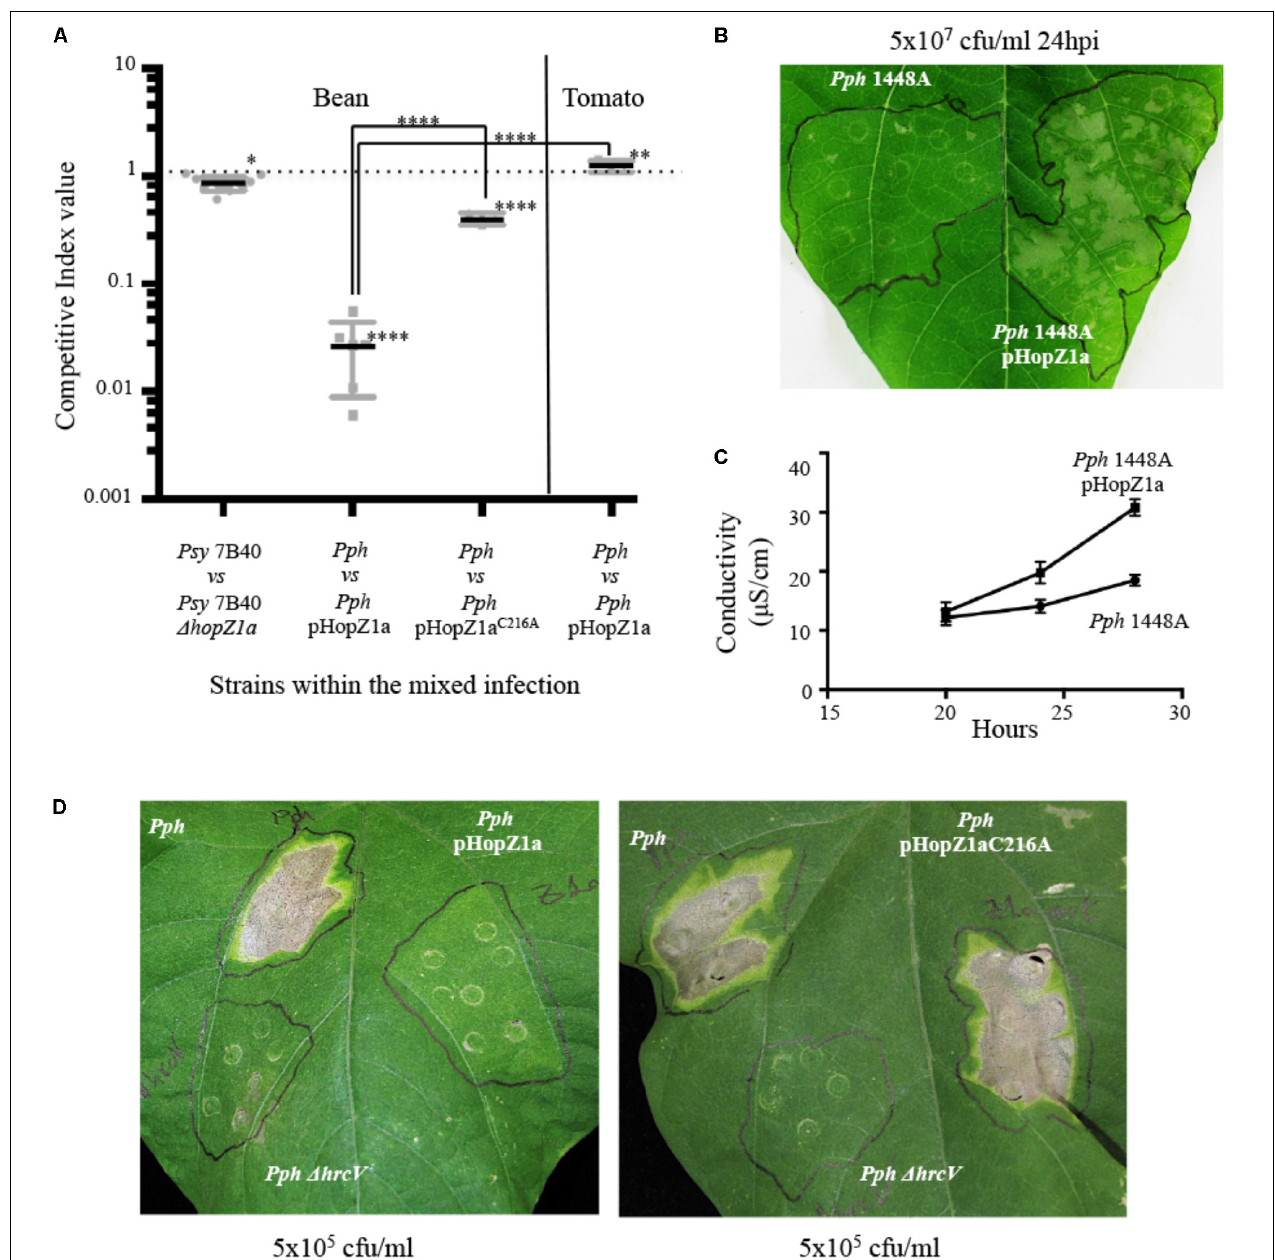
FIGURE 1 | HopZ1a triggers immunity in bean. (A) Competitive indices (CIs) measuring proliferation in leaves of Psy 7B40 or Pph 1448A, either carrying a (cid:49) hopZ1a mutation, pHopZa1 (pAME30) or pHopZ1a C216A (pAME27) related to proliferation of Psy 7B40 or Pph 1448A, as corresponds, in bean or, as indicated. CIs are calculated as the output ratio between the strain lacking or expressing the effector and the corresponding wild type strain, divided by their input ratio. Each CI mean represents at least three independent experiments with three biological replicates each. Individual values are shown for each CI. Error bars represent the standard error. Mean values marked with asterisk(s) were found significantly different from 1.00 or from each other as established by Student’s t -test ( ∗ P < 0.05; ∗∗ P < 0.01; ∗∗∗∗ P < 0.001). (B) Hypersensitive response to hand-infiltration of bean leaves with bacterial suspensions containing 5 × 10 7 cfu/ml of Pph 1448A-carrying or not pHopZ1a (pAME30). Photographs were taken 24 h post-inoculation. Image is representative of at least three inoculated leaves per strain and experiment. The experiment was repeated at least twice with similar results. (C) Conductivity assays on bean leaves carried out at different time points post-inoculation with 5 × 10 7 cfu/ml of Pph 1448A-carrying or not pHopZ1a (pAME30). The graph shows results from two independent experiments with three inoculated leaves per strain and experiment. (D) Disease symptoms to hand-infiltration of bean leaves with bacterial suspensions containing 5 × 10 5 cfu/ml of Pph 1448A-carrying pHopZ1a (pAME30) or pHopZ1a C216A (pAME27), or a (cid:49) hrcV mutation. Photographs were taken 7 days post-inoculation. Images are representative of at least three inoculated leaves per strain and experiment. The experiment was repeated at least twice with similar results.